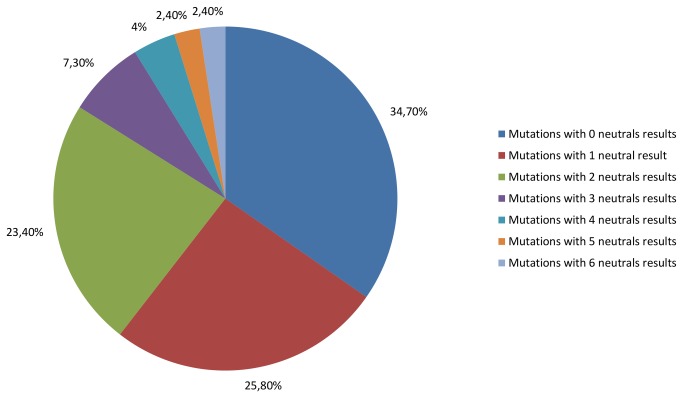
Percentage of mutations with neutral results obtained by the algorithms used for analysis of SOD1.Blue bar represents the percentage of mutations that, among the seven used algorithms, presented no neutral result and were therefore considered malign by all algorithms. Red bar, the percentage of mutations with neutral results; Green bar, 2 neutral results; Purple bar, 3 neutral results; Yellow bar, 5 neutral results; Orange bar, 6 neutral results; Brown bar, 7 neutral results.